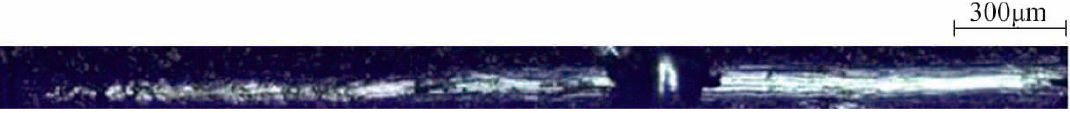
Figure 9. Test results of adhesion of the DLC coating to the Ti-13Nb-13Zr alloy—sand-blasted.